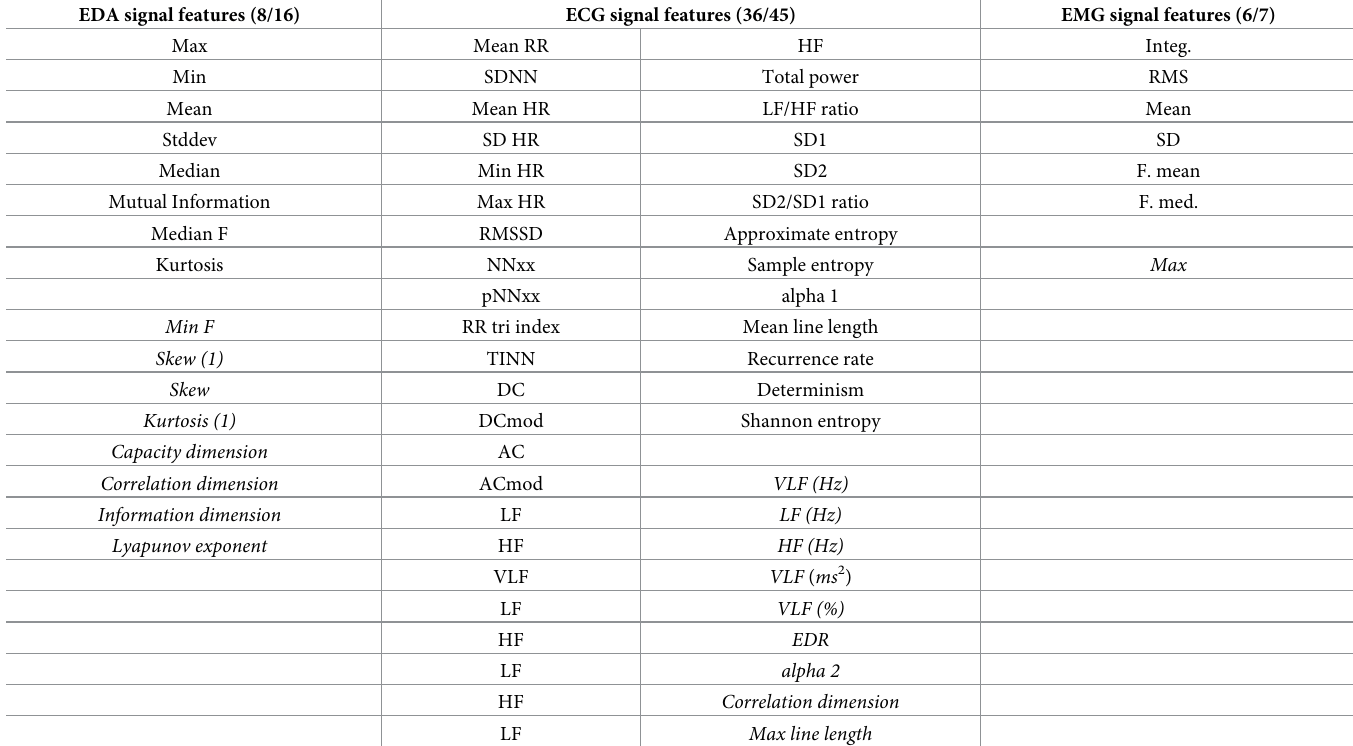
Table 4. Sixty-eight extracted signal features (all) and 50 reduced features (Italics are deleted features). EDA signal features